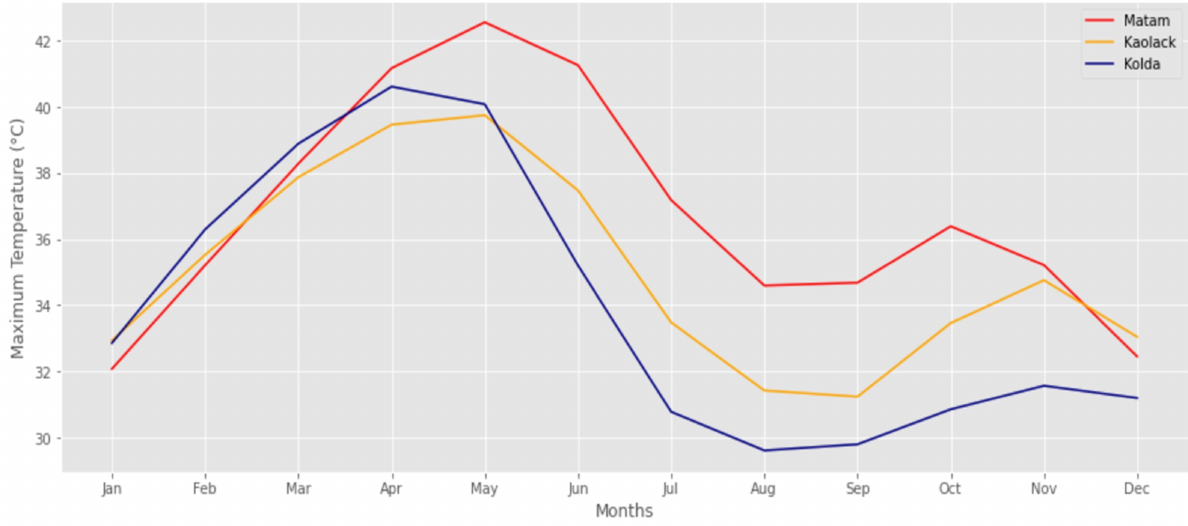
Figure 8. Monthly average Maximum Temperature for Matam, Kaolack and Kolda